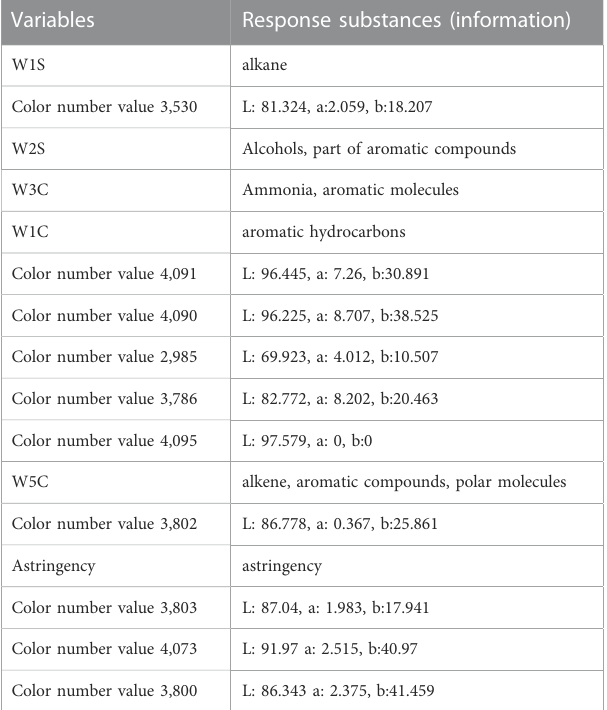
TABLE 4 Response substances (information) of variables with VIP > 1.